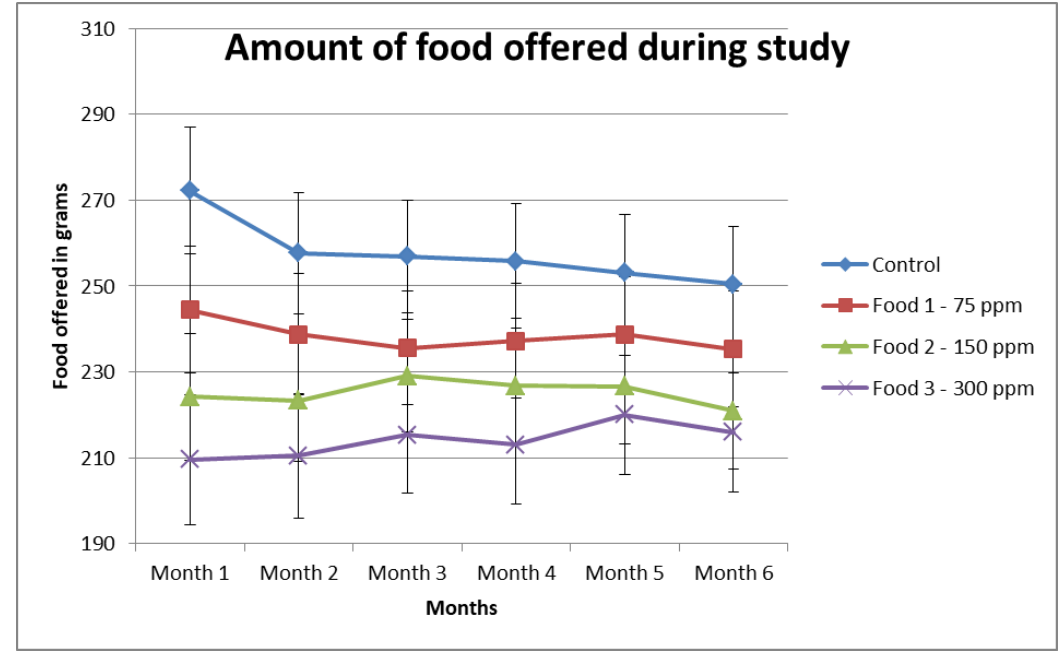
. Figure A3. Mean a-LA concentration in ppm in the different Foods analyzed by High-Pressure Liquid Chromatography Control, Food 1, Food 2 and Food 3 have 0 ppm, 75 ppm, 150 ppm and 300 ppm of a-LA respectively.